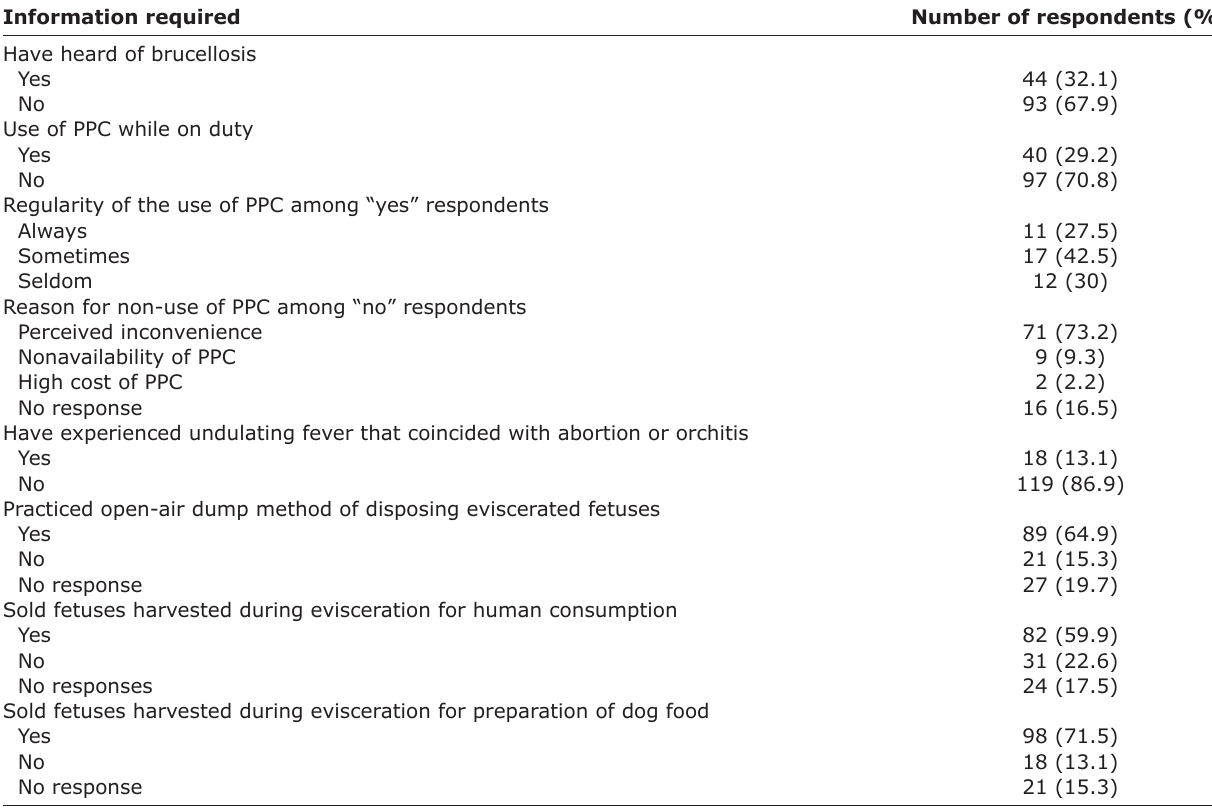
Table-4: Awareness of brucellosis and slaughterhouse practices among slaughterhouse workers (n=137) surveyed in Enugu State, Nigeria. Information required